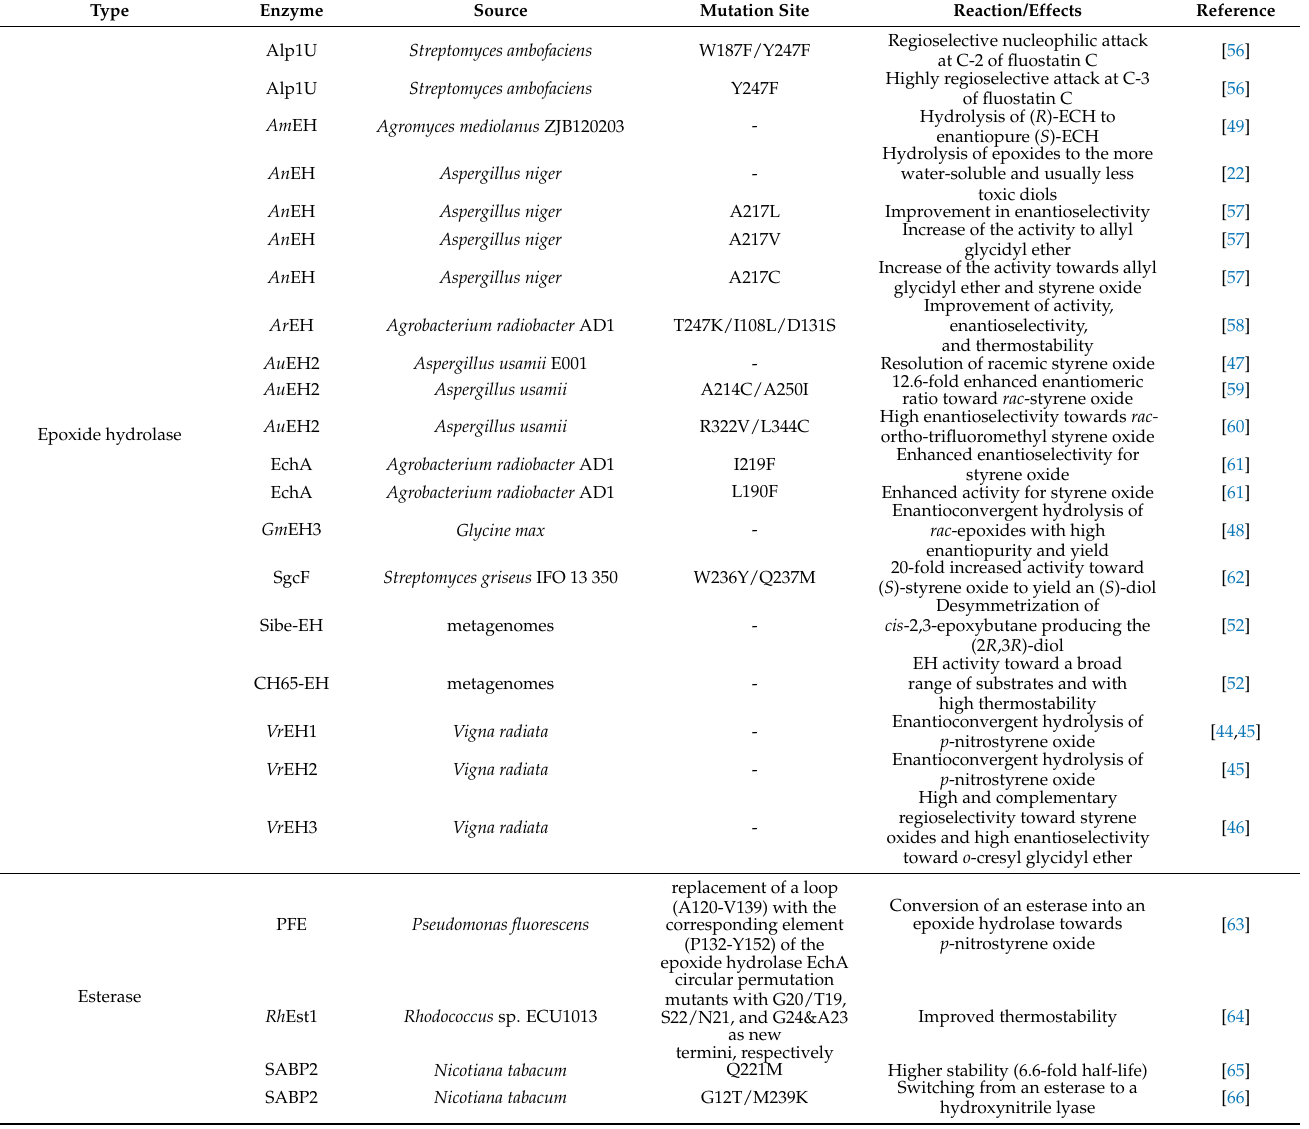
Table 1. Native and engineered α / β hydrolases for chiral chemical